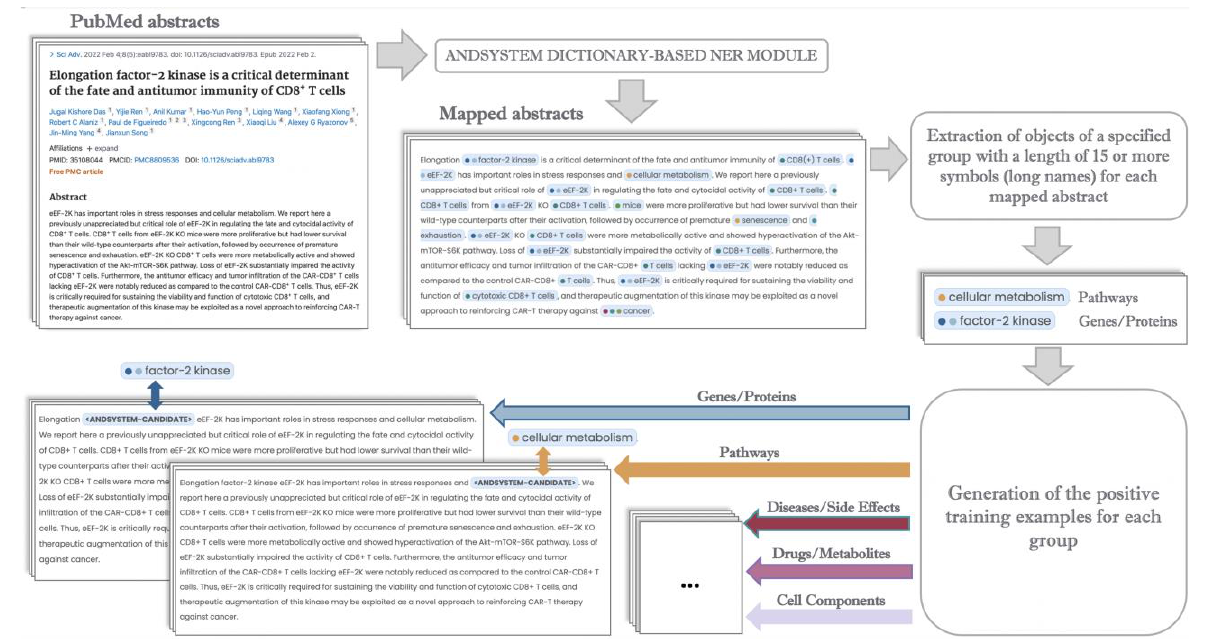
Figure 8. The algorithm scheme for generating training examples for fine-tuning the ANDDigest ver. 01.2022 classification models.